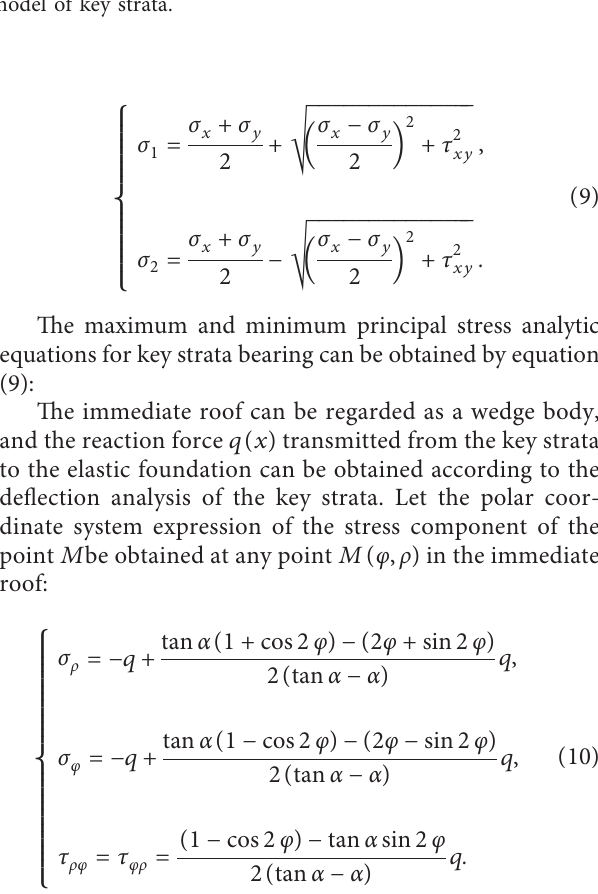
Figure 3: Mechanical model of key